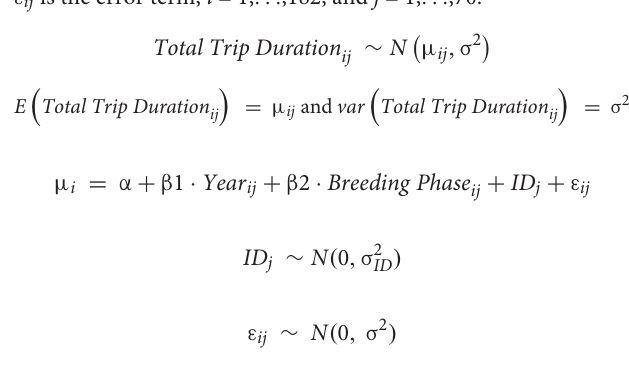
Equation 1. The general linear mixed model relating Total